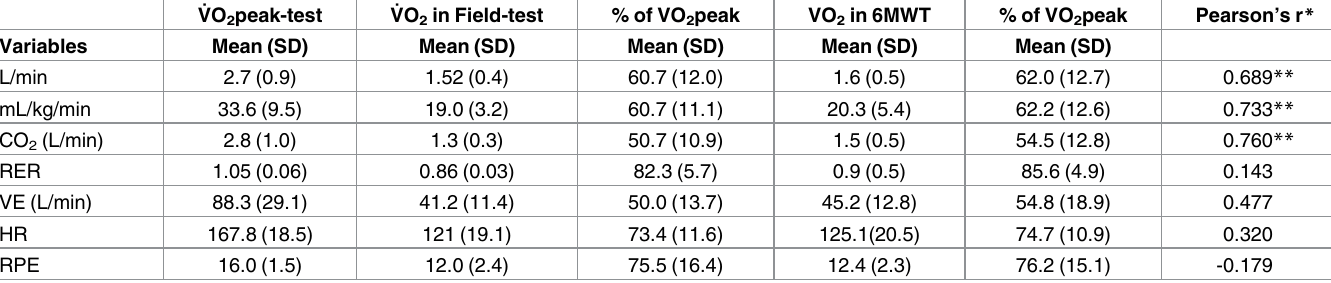
Table 4. Relevant variables at V˙O 2 peak, during field-testing and proportion of aerobic capacity (n =